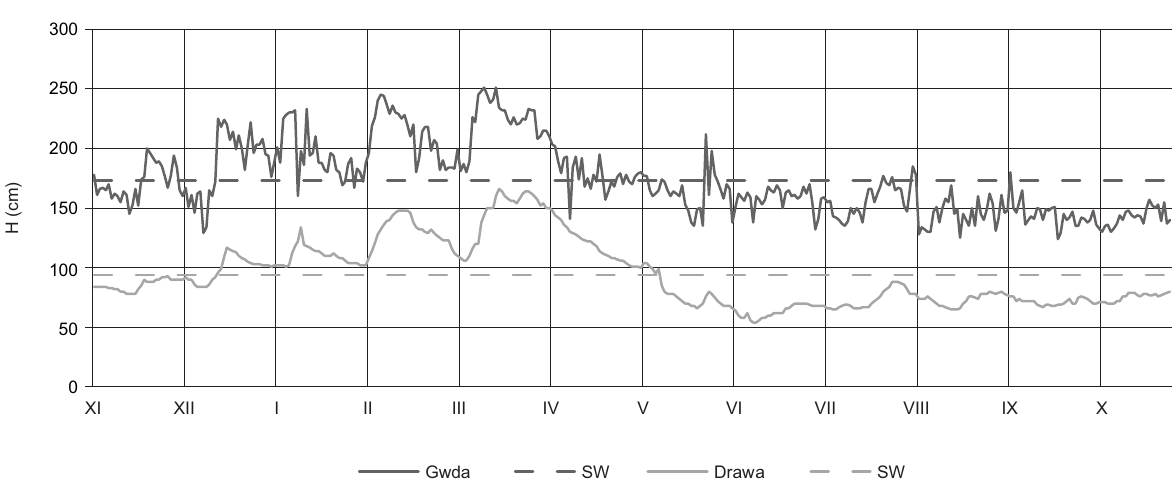
Fig. 4. Daily water stages of the Gwda River in Piła and the Drawa River in Drawiny in hydrological year 1981 (wet year)